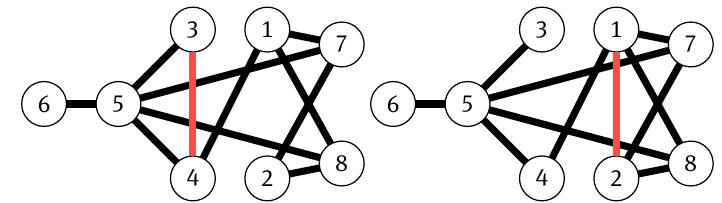
Figure 5: Graphs that are D L but not D L -cospectral using the cousins construction